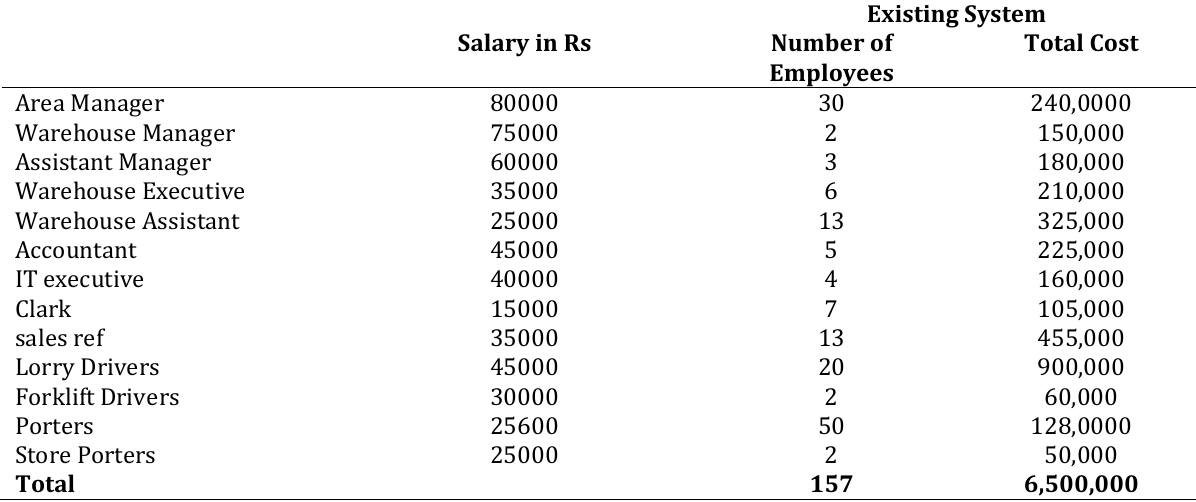
Table 8: Salary cost analysis of the existing